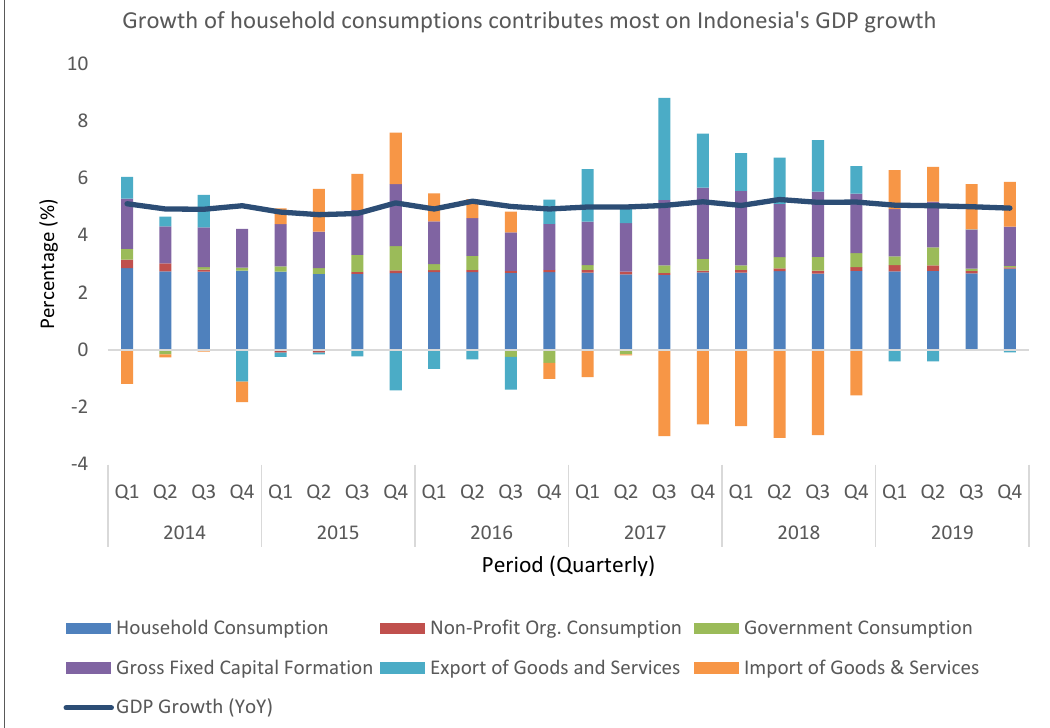
Fig. 2: Contribution to gross domestic product (GDP) growth by expenditure accounts (BPS, 2020 Fig. 1: Contribution to gross domestic product (GDP) growth by expenditure accounts